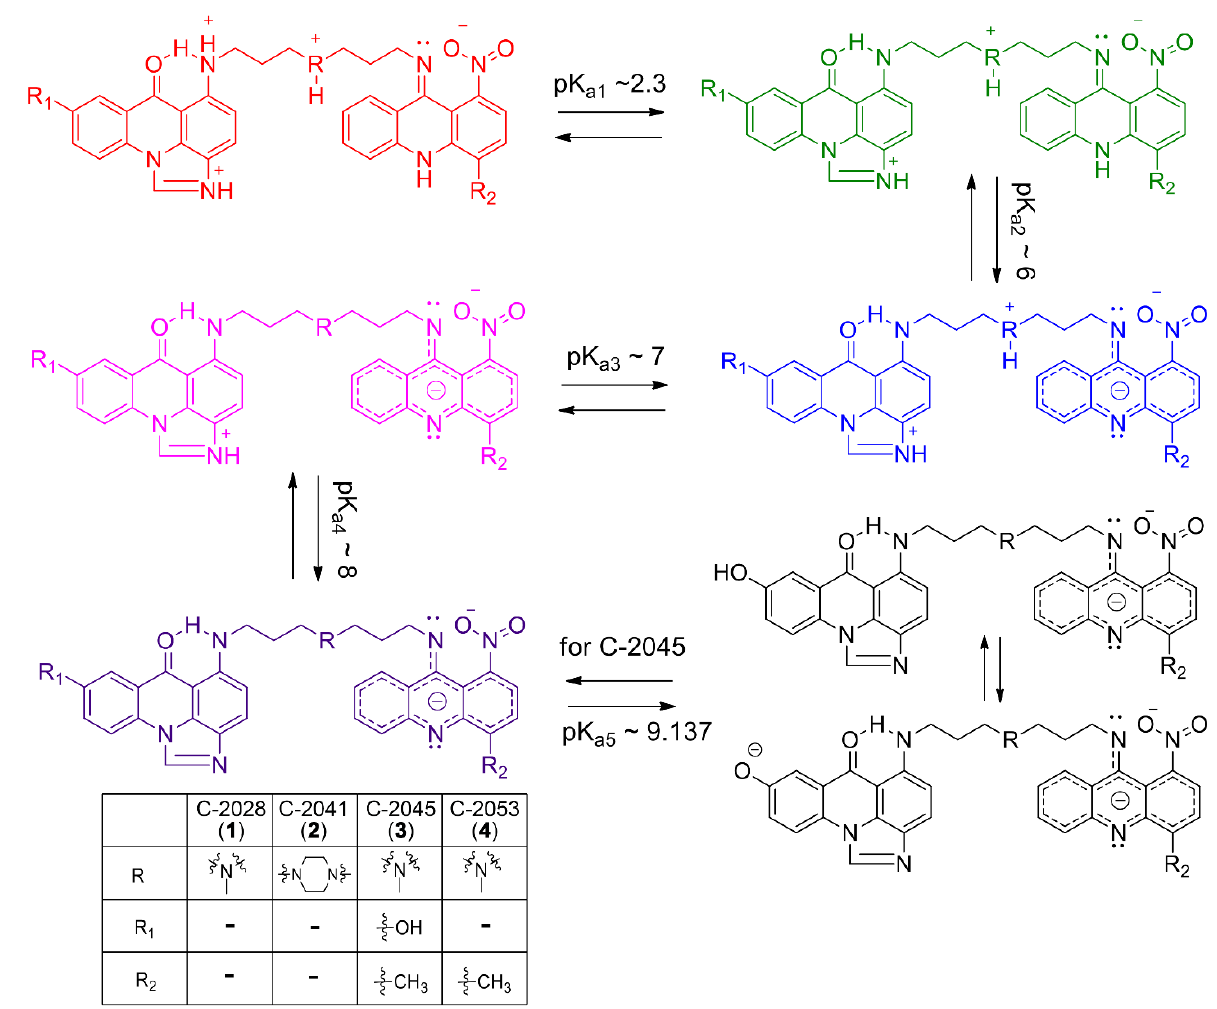
Figure 5. Proposed structures of individual pH-dependent forms of studied UAs ( 1 – 4 ) and the corresponding approximated pK a values. C–2045 ( 3 , black structures) was used as an example for the last pK a = 9.137.